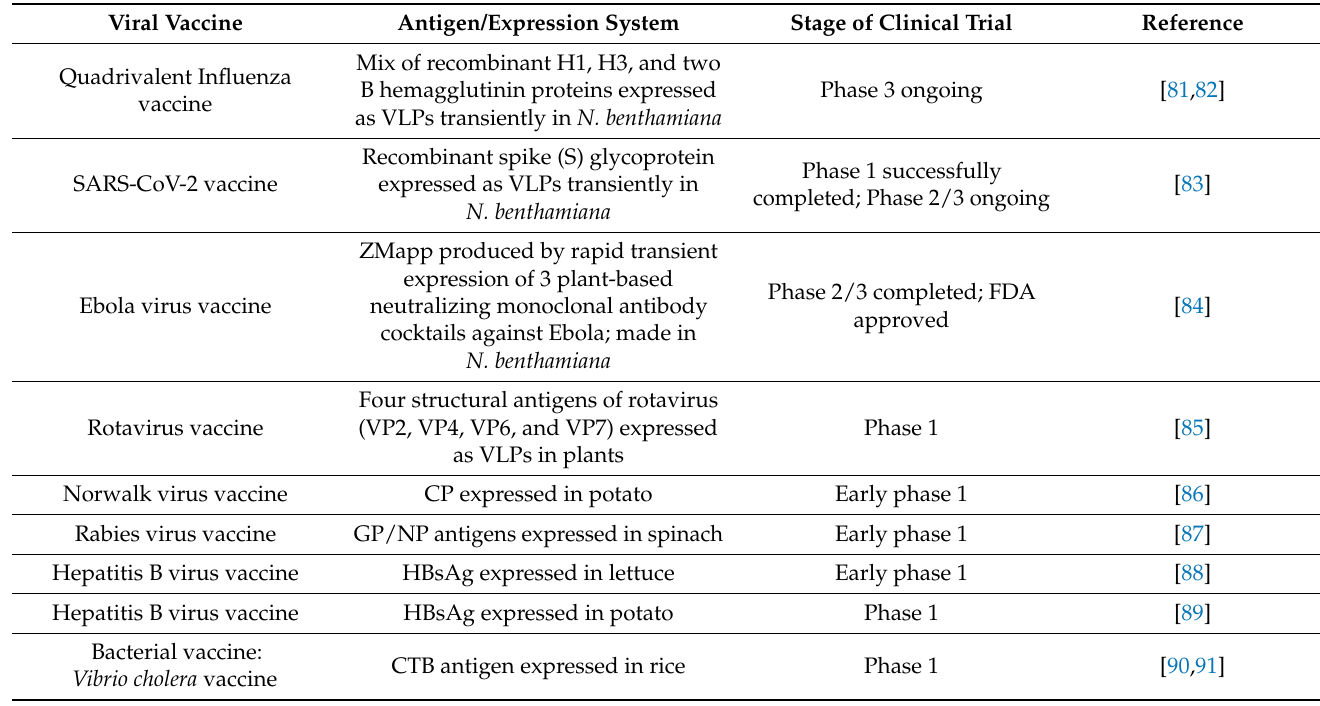
Table 1. Plant-based viral vaccines currently under clinical